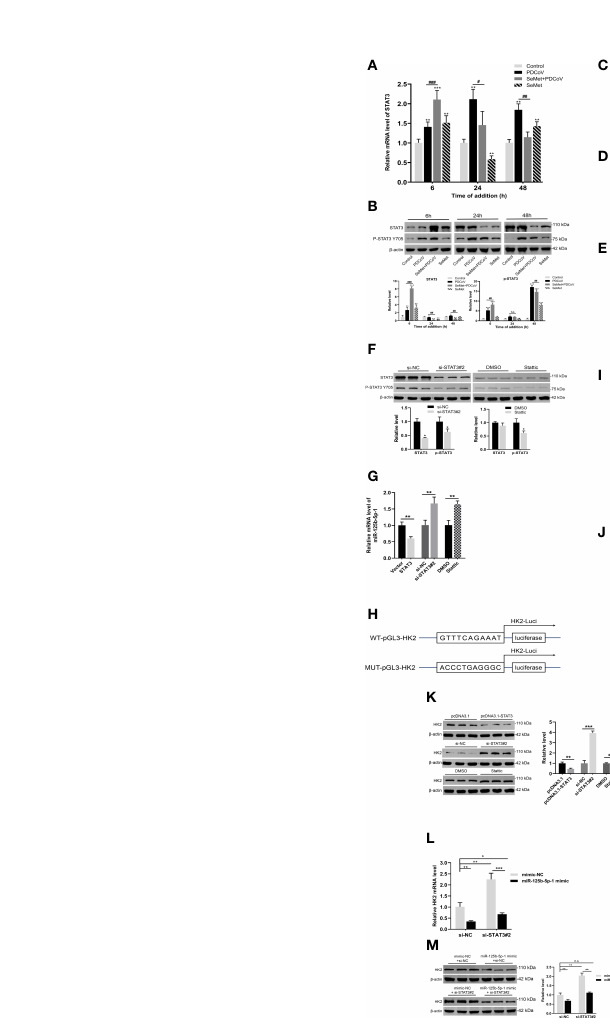
FIGURE 4 STAT3 directly regulates miR-125b-5p-1 expression. (A, B) LLC-PK1 cells were treated with PDCoV (100 TCID 50 ) and SeMet (150 m M) for 6, 24, and 48 h, and the level of STAT3 and phos-STAT3 (Tyr705) was determined by qRT-PCR or Western blot (n=3-6). (C) The base sequence and mutant sequence of miR-125b-5p-1 promoter. (D) The STAT3 protein expressions was determined by qRT-PCR and Western blot in LLC-PK1 cells when transfected with pcDNA3.1-vector or pcDNA3.1-STAT3 (n=3). (E) The pcDNA3.1-STAT3 or empty vector and WT-pGL3-miR-125b-1 or MUT- pGL3-miR-125b-1 were co-transfected into HEK293T cells. The luciferase reporter assay was used to detect whether STAT3 can target and bind on miR-125b-1 promoter (n=5). (F) The STAT3 protein expression was determined by qRT-PCR or Western blot in LLC-PK1 cells treated with siRNA-NC, siSTAT3, DMSO, and Stattic (STAT3 inhibitor, 0.75 m M) (n=3). (G) The miR-125b-5p-1 expression was measured by qRT- PCR when transfected with pcDNA3.1-STAT3, empty vector, siSTAT3, siRNA-NC, DMSO, Stattic (0.75 m M) (n=6). (H) The base sequence and mutant sequence of HK2 promoter. (I) The pcDNA3.1-STAT3 or empty vector and WT-pGL3-HK2 or MUT- pGL3-HK2 were co-transfected into HEK293T cells. The luciferase reporter assay was used to detect whether STAT3 can target and bind on HK2 promoter (n=5). (J, K) The HK2 mRNA and protein expressions were determined by qRT-PCR and Western blot in LLC-PK1 cells when transfected with pcDNA3.1-STAT3, empty vector, siSTAT3, siRNA-NC, DMSO, Stattic (0.75 m M) (n=3-6). (L, M) The siSTAT3 or siRNA-NC and miR-125b-5p-1 mimic or mimic-NC were co- transfected into LLC-PK1 cells. The HK2 mRNA and protein expressions were determined by qRT-PCR and Western blot (n=3-6). Means ± SD are shown. Statistical signi fi ciance was determined by Student t test. ***, P <0.001; **, P <0.01; *, P <0.05; ### , P < 0.001; ## , P <0.01; # , P <0.05; n.s: not signi fi cant. All experiments were repeated at least twice and representative results are